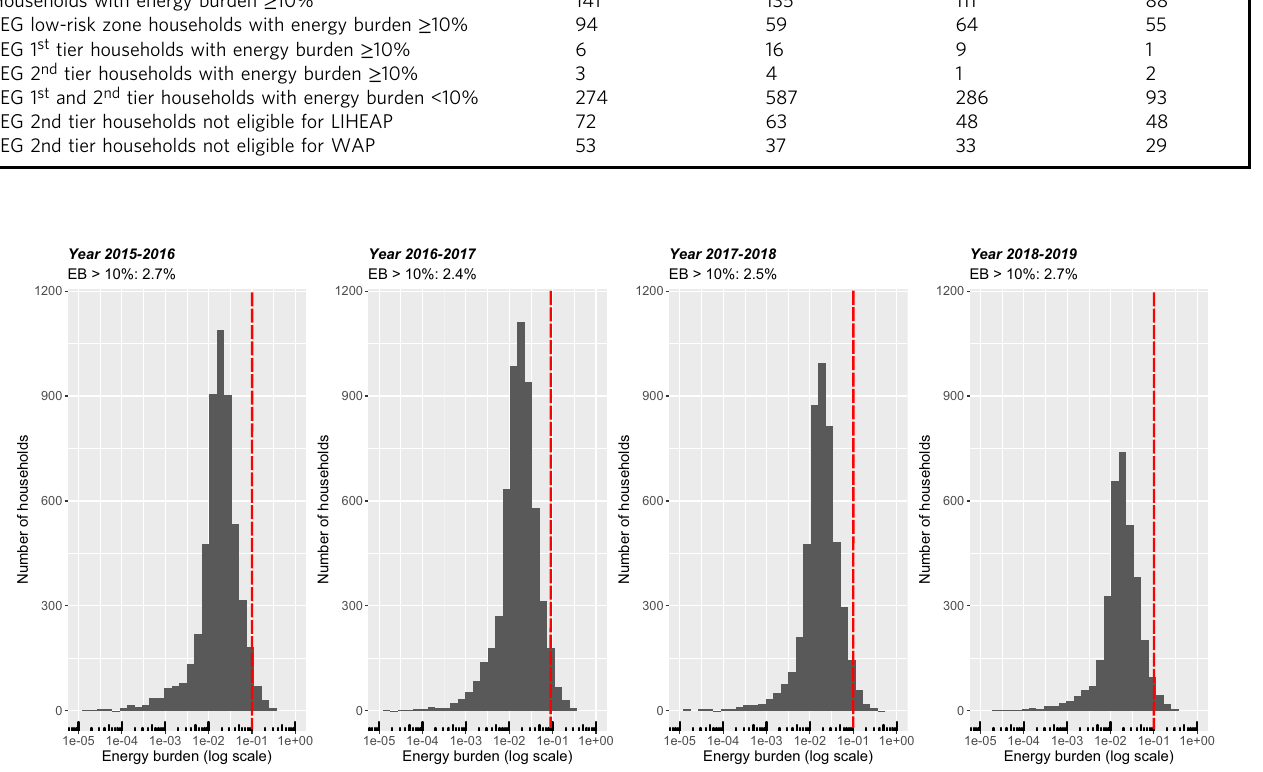
Fig. 7 Energy insecurity measured using the energy burden (EB) metric. The x -axis represents the percent of income a household spends on electricity. The red dotted line indicates the 10% income spending threshold, and EB10 details the proportion of households above the energy spending threshold. For example, in 2015 – 2016, 2.7% of households in our sample spent more than 10% of their income on electricity. The maximum amount of spending in our sample population is